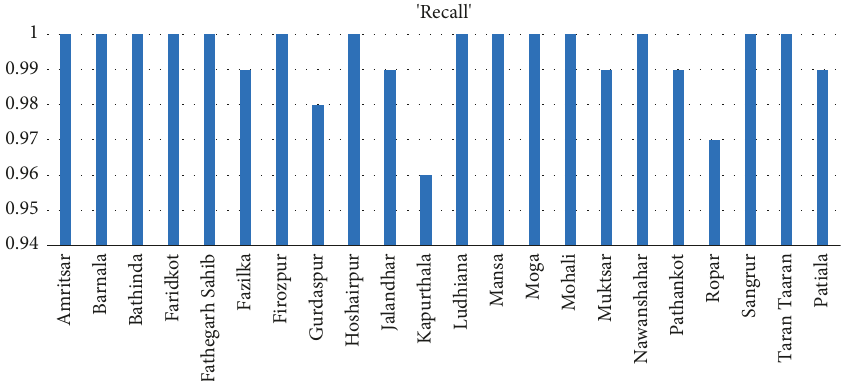
Figure 7: Recall for each